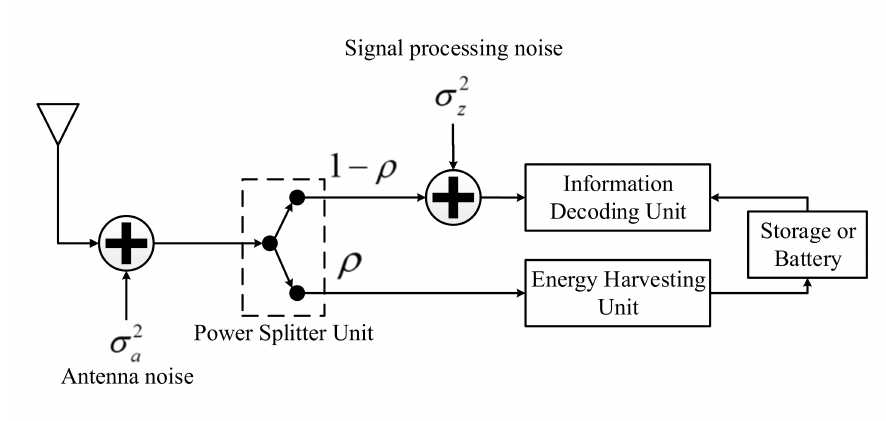
Figure 2. SWIPT receiver model with power splitting